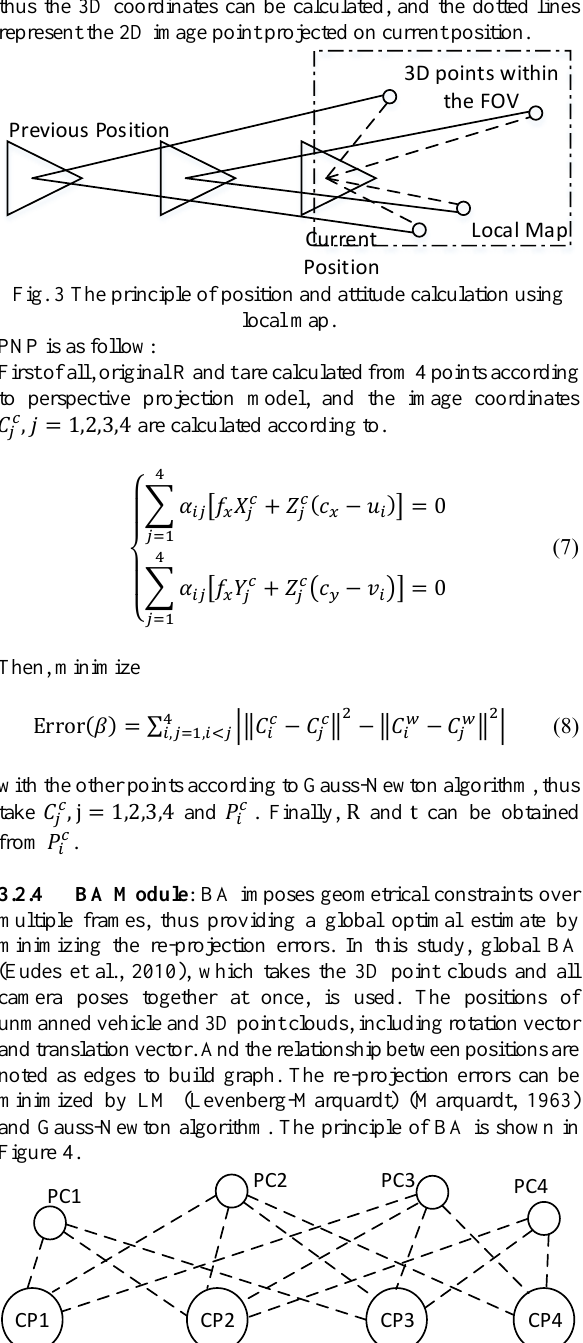
Fig. 4 The principle of BA.